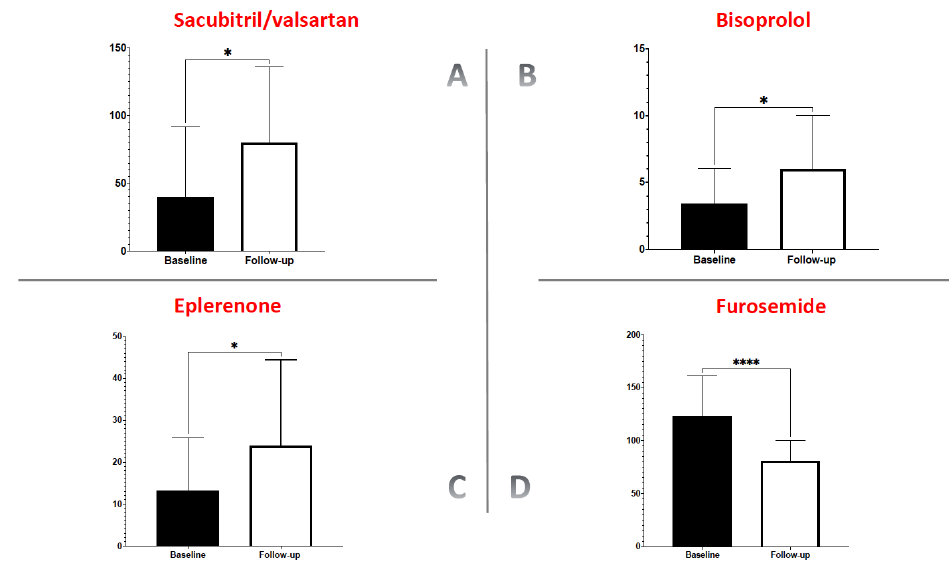
Figure 2. Change in the dose of disease modifier drugs (panel A – C ) and diuretics at follow-up (panel D ). *: p < 0.05; ****: p < 0.0001.